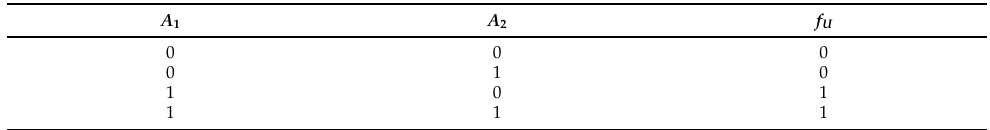
Table 8. Boolean relations for two